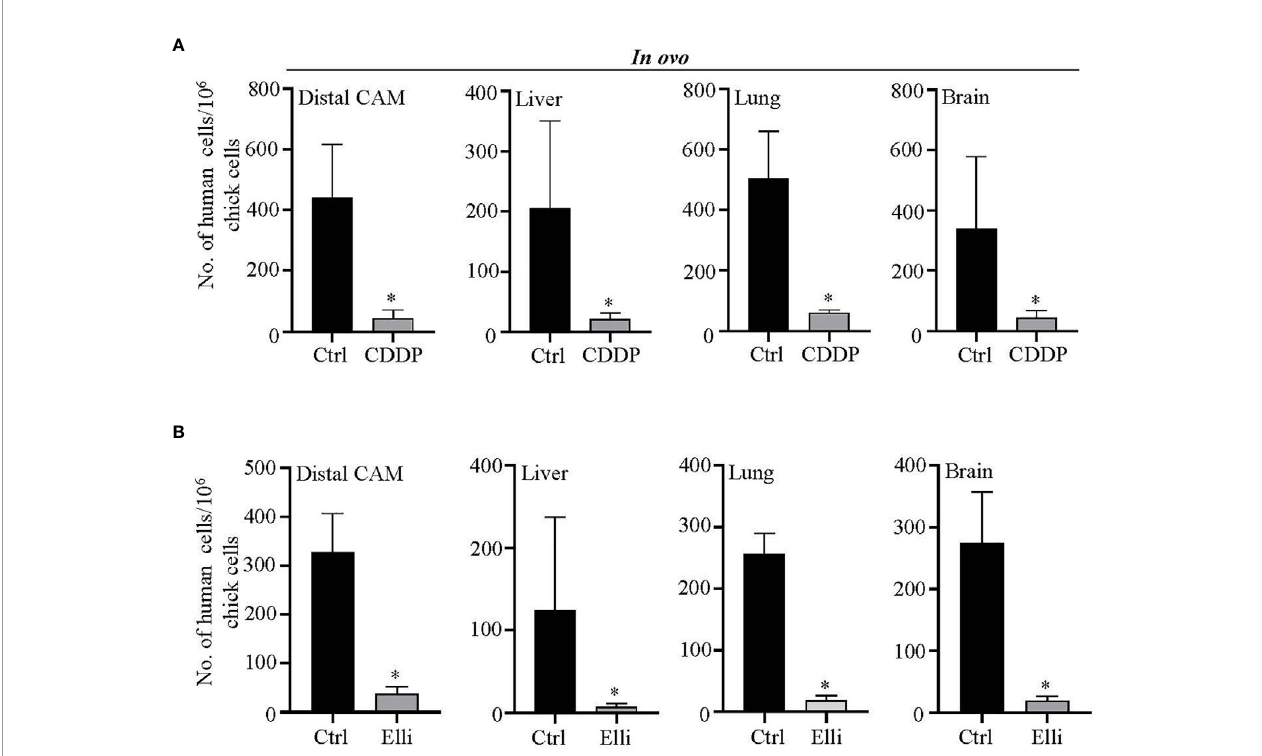
FIGURE 5 | Evaluation of ef fi ciency of (A) cisplatin (CDDP) and (B) ellipticine (Elli) to inhibit metastatic spread of UKF-NB-4 cells to distal chick chorioallantoic membrane (CAM) and selected organs. qPCR quantitation of human (neuroblastoma (Nbl)) cells using universal Alu primers. As internal control used to validate the presence of equivalent amount of host (chicken) genomic DNA, we employed chicken GAPDH primers. Data show mean ± SEM from three ( n = 3) independent experiments. * p <